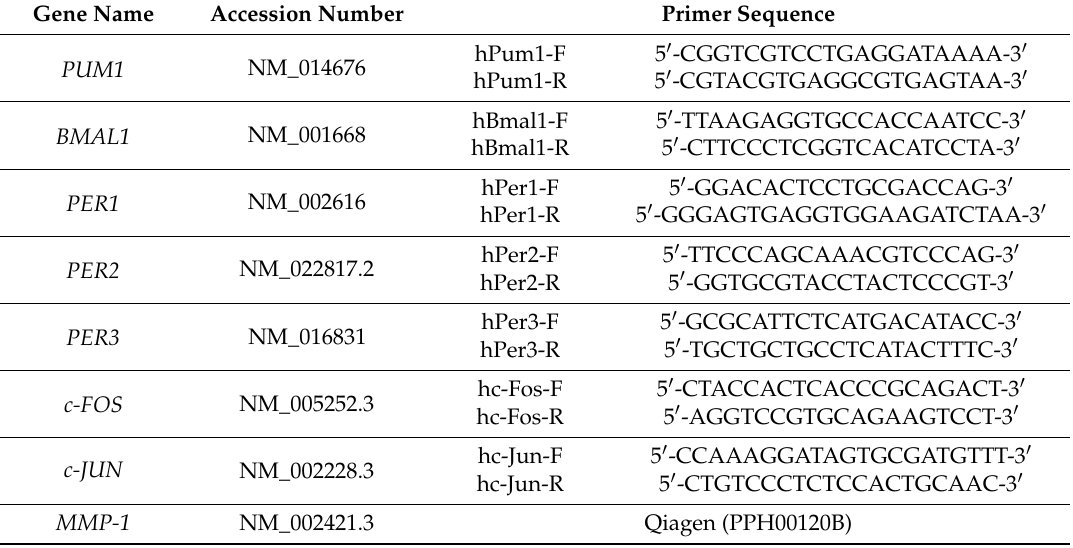
Table 2. List of primer